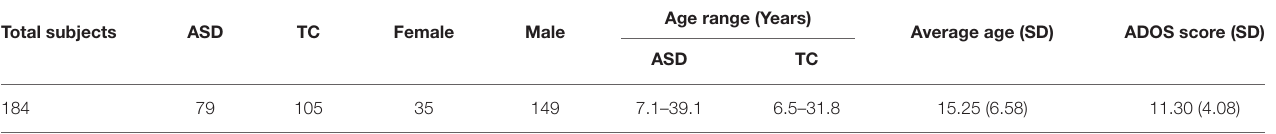
TABLE 2 | NYU phenotypic data information for ABIDE-I database.